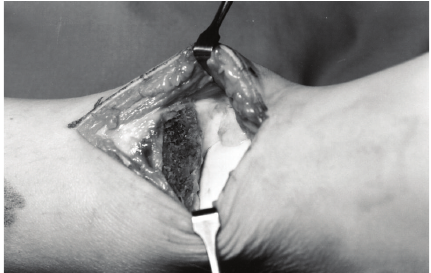
Figure 2: Intraoperative image of the removed lesion using a medial longitudinal incision.